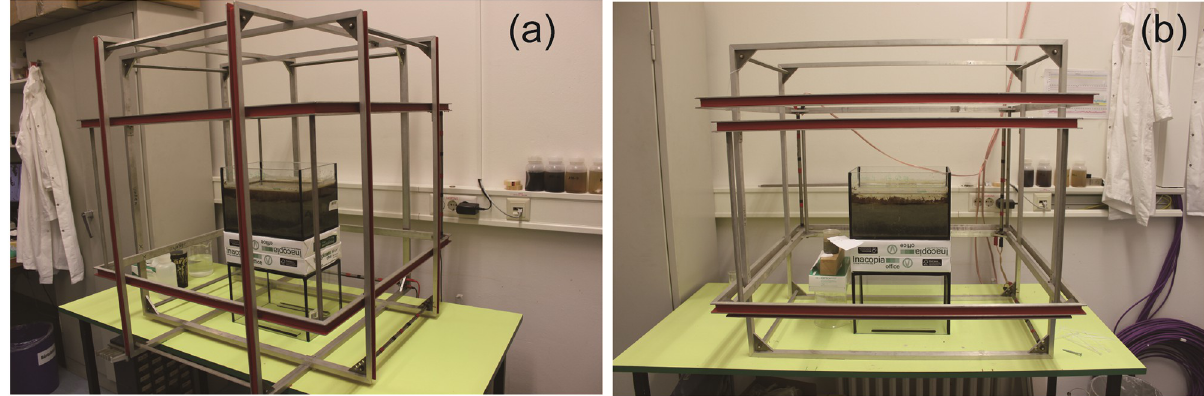
Fig 1. Magnetic field setups in zero field (a) and vertically alternating field (b). The zero field condition was generated by three pairs of Helmholtz coils, in which sediment microcosm was placed in the center for guarantee of near-to-zero magnetic field during the experiment. In (b), two pairs of Helmholtz coils were used to compensate external horizontal and vertical field components and the third pair was responsible for reversing vertical field component. The switch upward and downward field every 24 hours was executed by an electronically controlled commutator. The downward field intensity was 118–121.5 μ T and upward field intensity was -123- -120 μ